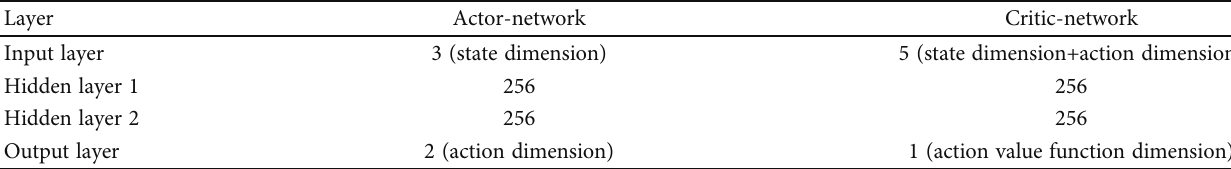
Table 1: Dimensions of each layer of the actor- and critic-networks.